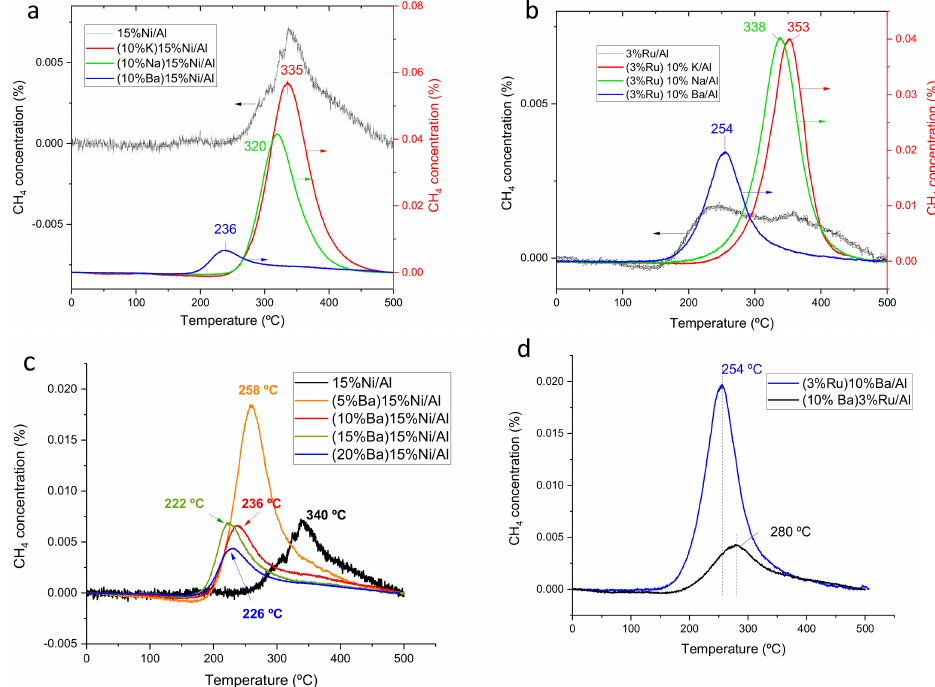
Figure 6. Temperature-programed surface reaction (TPSR) experiments of CO 2 pre-adsorbed at 50 ◦ C on the different catalysts. ( a ) Comparison of catalysts of the Ni series, ( b ) comparison of catalysts of the Ru series, ( c ) comparison of catalysts containing different amounts of Ba, ( d ) comparison